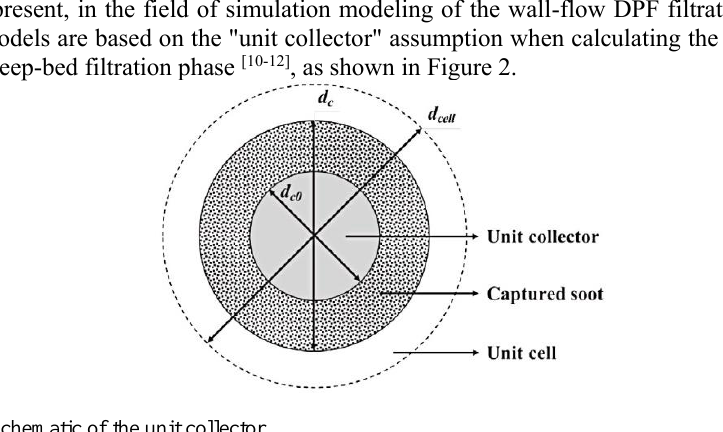
Fig. 2. Schematic of the unit